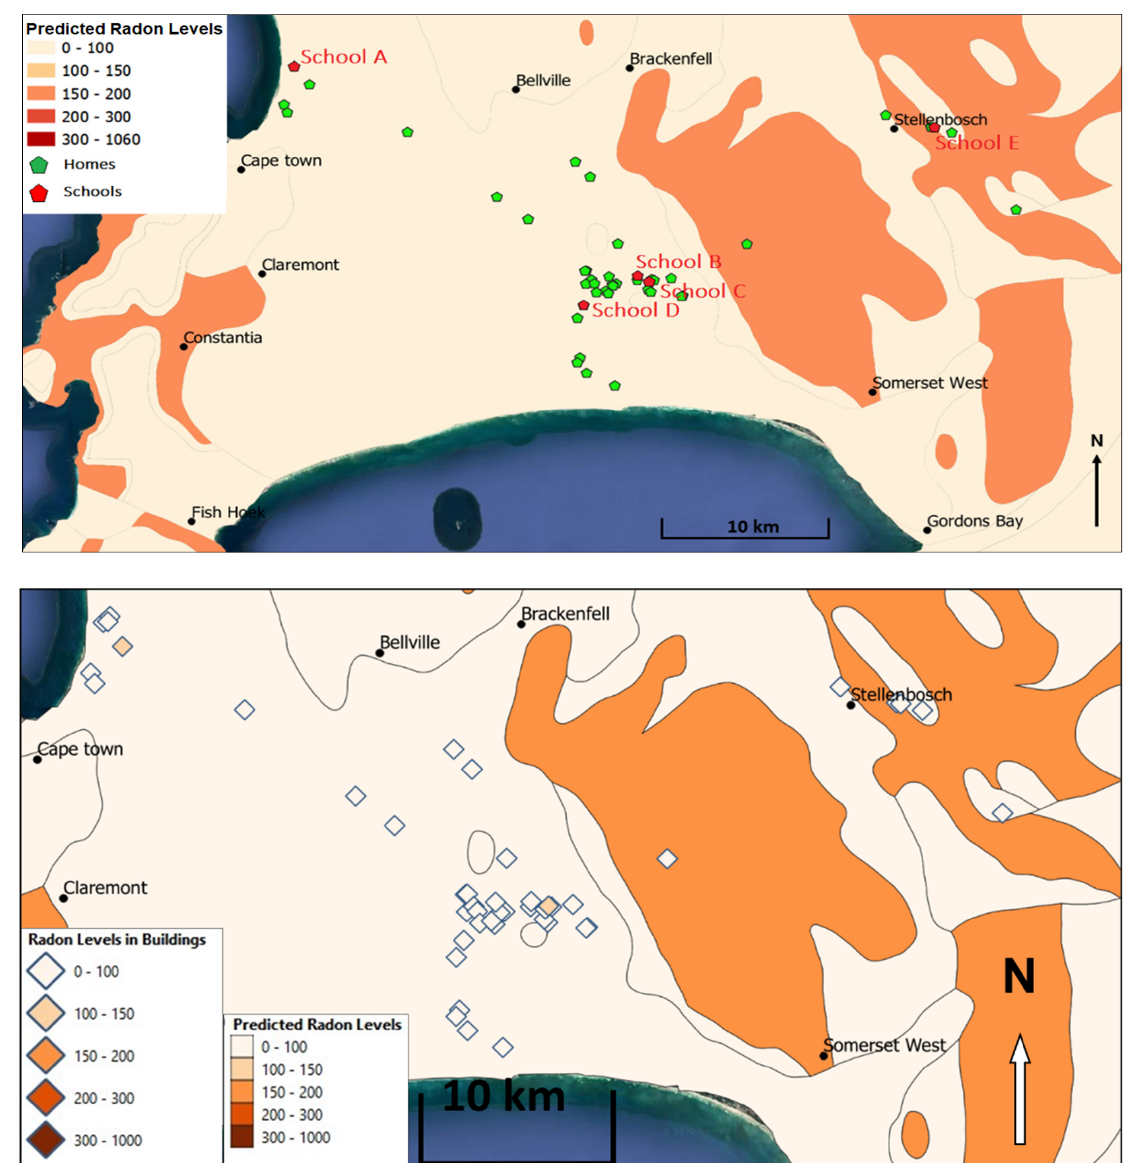
Figure 5. Western Cape map showing the measurement location and measured and predicted indoor radon levels using Bezuidenhout’s model [12].